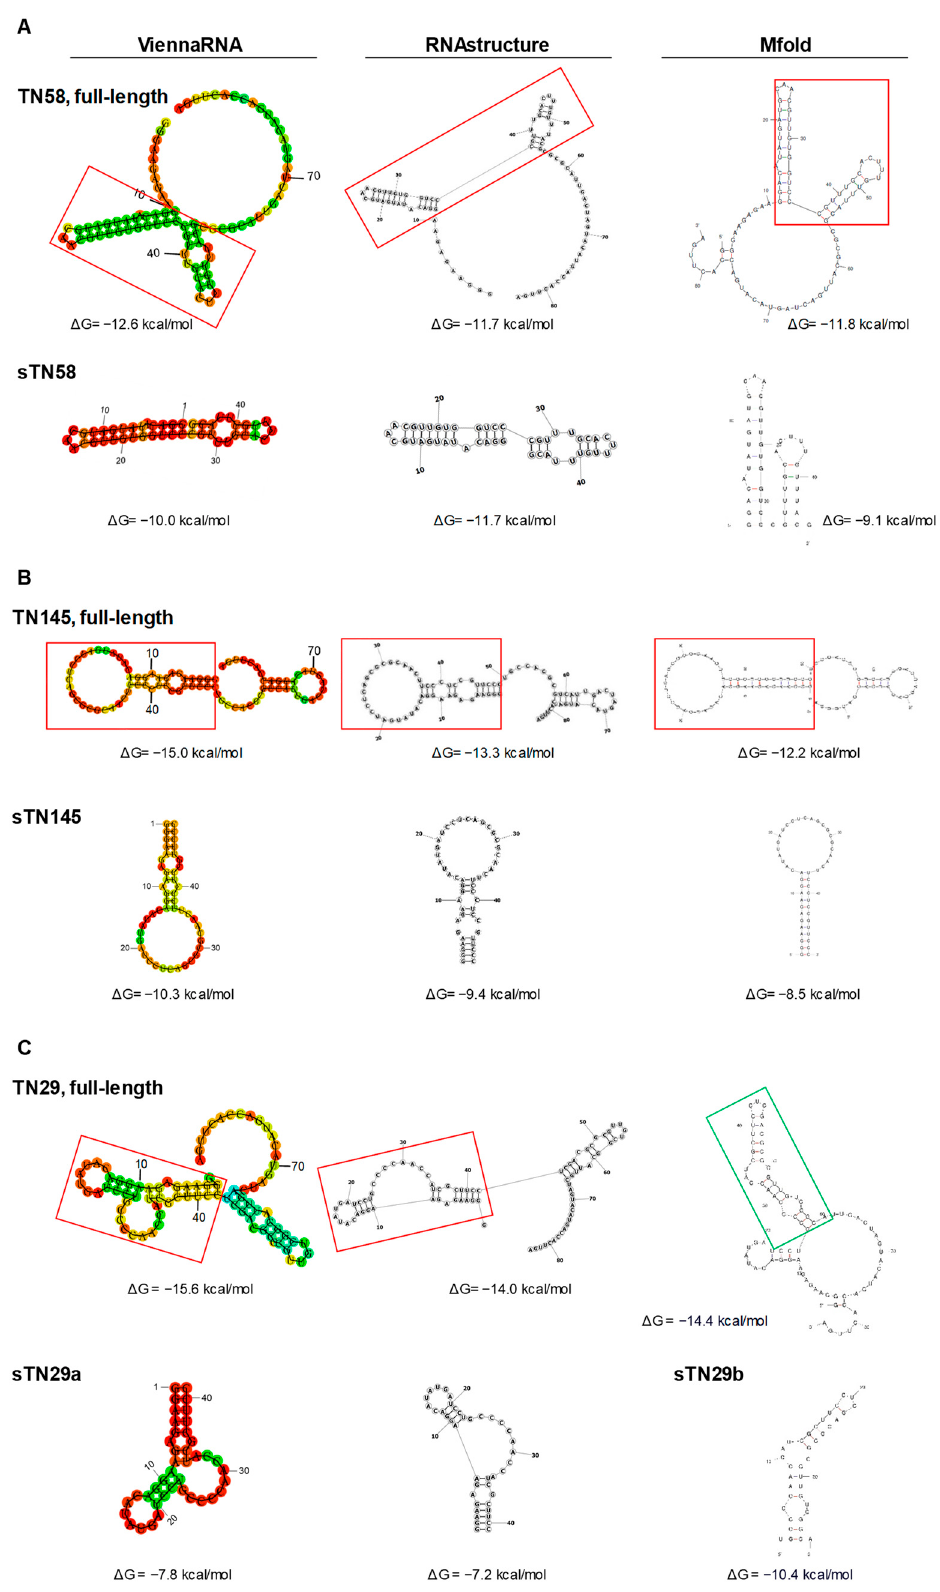
Figure 1. Secondary structure of full-length and short aptamers. Secondary structures of TN58 ( A ), TN145 ( B ) and TN29 ( C ) aptamers were predicted by ViennaRNA Package, RNAstructure and Mfold. Δ G values are reported. Boxes indicate the potential binding sites.